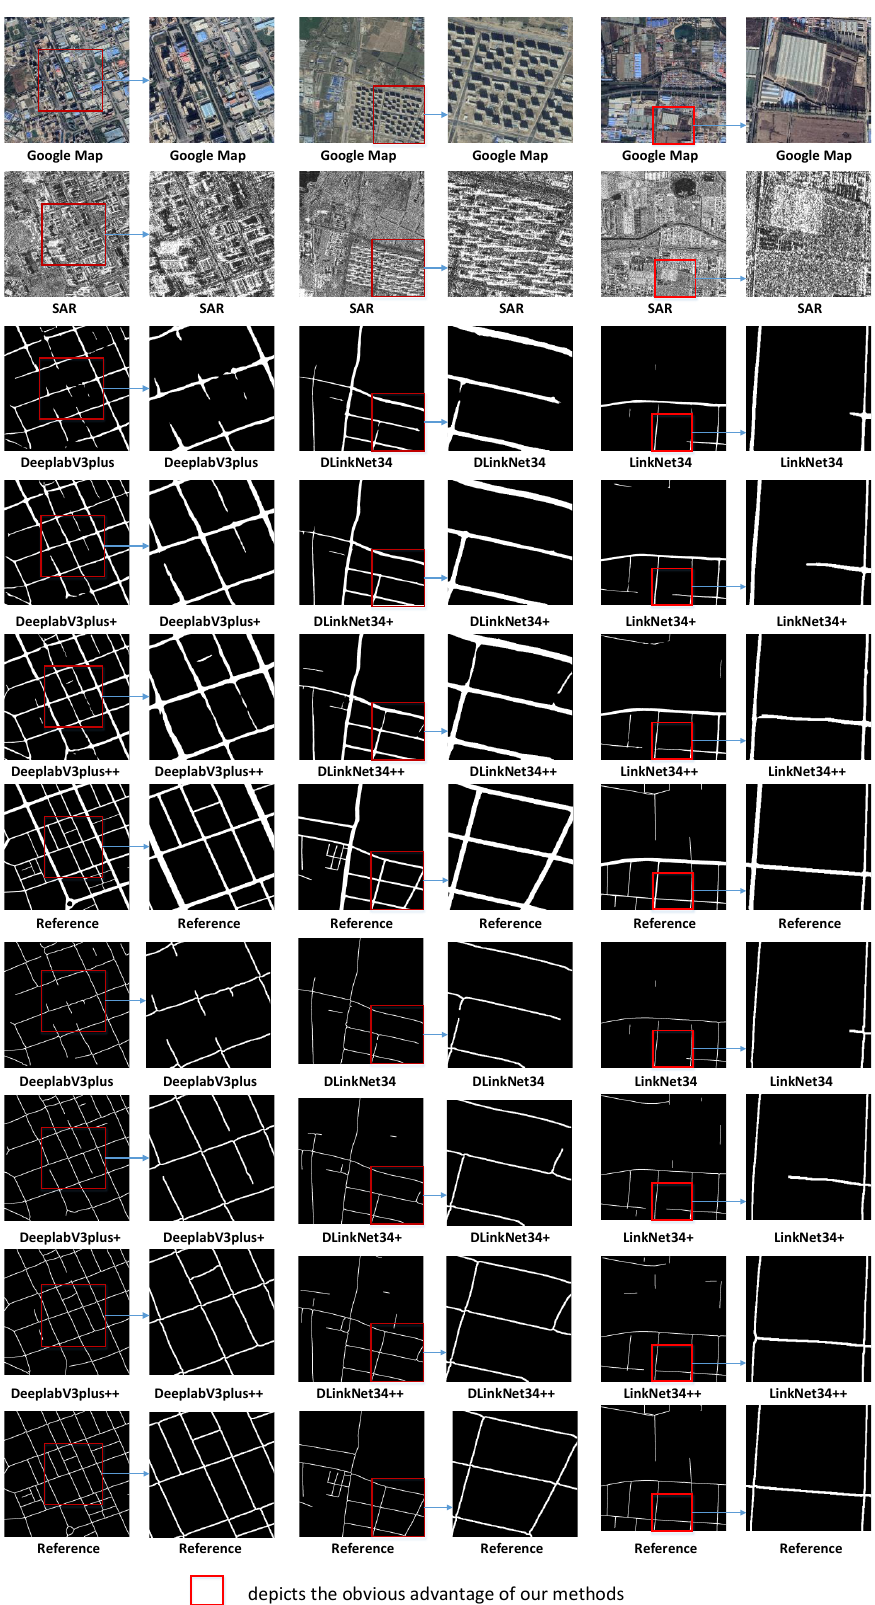
Figure 7. Qualitative comparison of road extraction results produced by different methods. For visualization, we performe the morphological dilation operation on the road centerline extraction